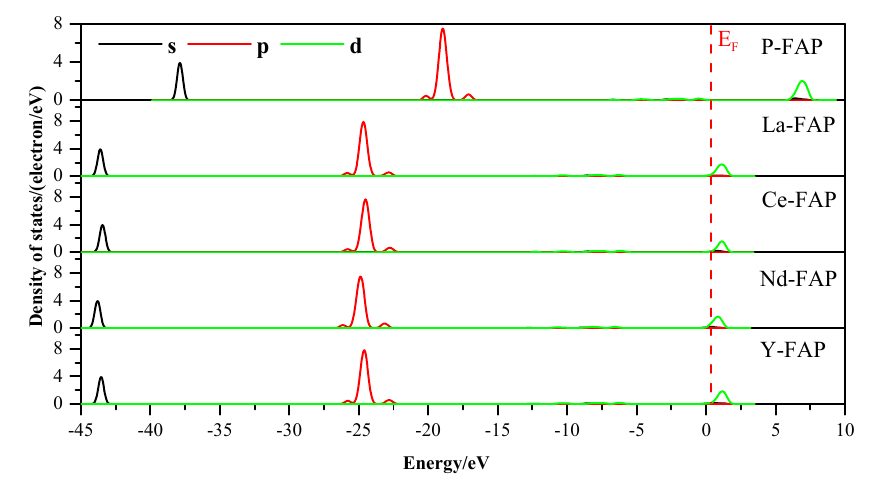
Figure 7. PDOS of a single Ca atom adjacent to the rare earth atom in REE-FAP crystals.